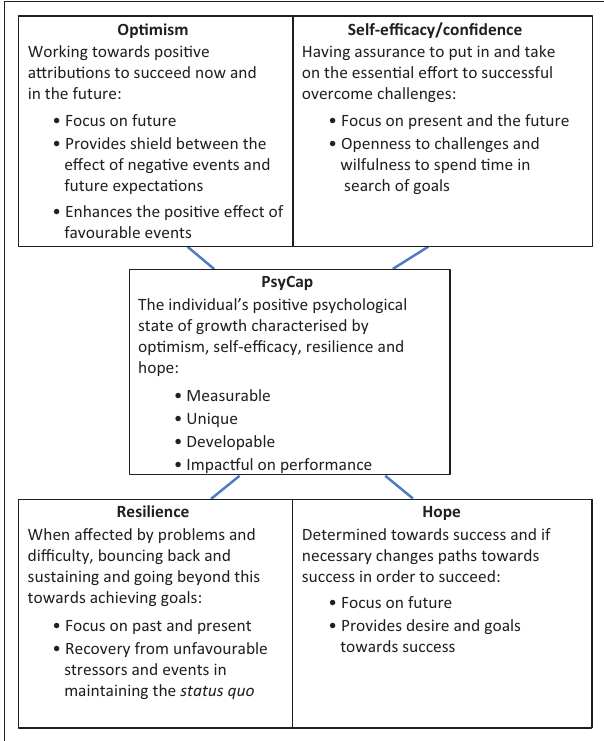
FIGURE 1: The individual PsyCap